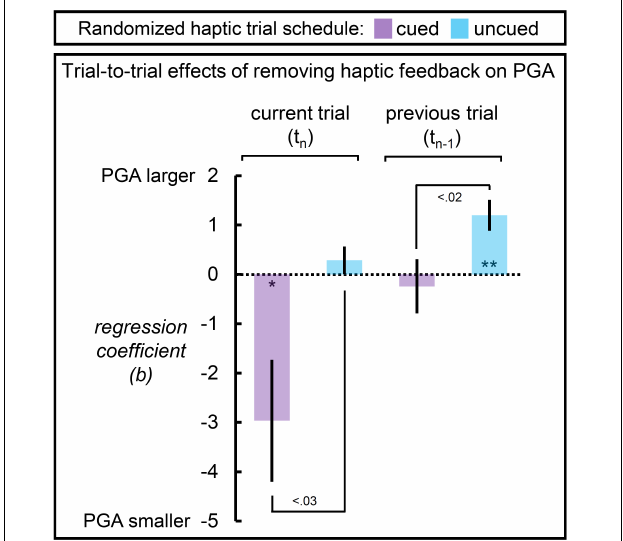
FIGURE 5 | Peak grip aperture as a function of the unique effects of removing haptic feedback on the current (upcoming) and immediately preceding trial for the randomized haptic trial schedules. When participants were reliably cued that haptic feedback would not be available on the current trial, PGA decreased; but when cues were unreliable, the availability of haptic feedback on the current trial was not predictive of PGA on the current trial. The reverse pattern was observed with respect to the availability of haptic feedback on the previous trial. When cues were reliable, the availability of haptic feedback on the previous trial was not predictive of PGA; but when cues were unreliable, an absence of haptic feedback on the previous trial led to an increase in PGA. Dotted line reflects a null effect of the haptic feedback removing haptic feedback. Error bars reflect SEMs. * p < 0.05; ** p <